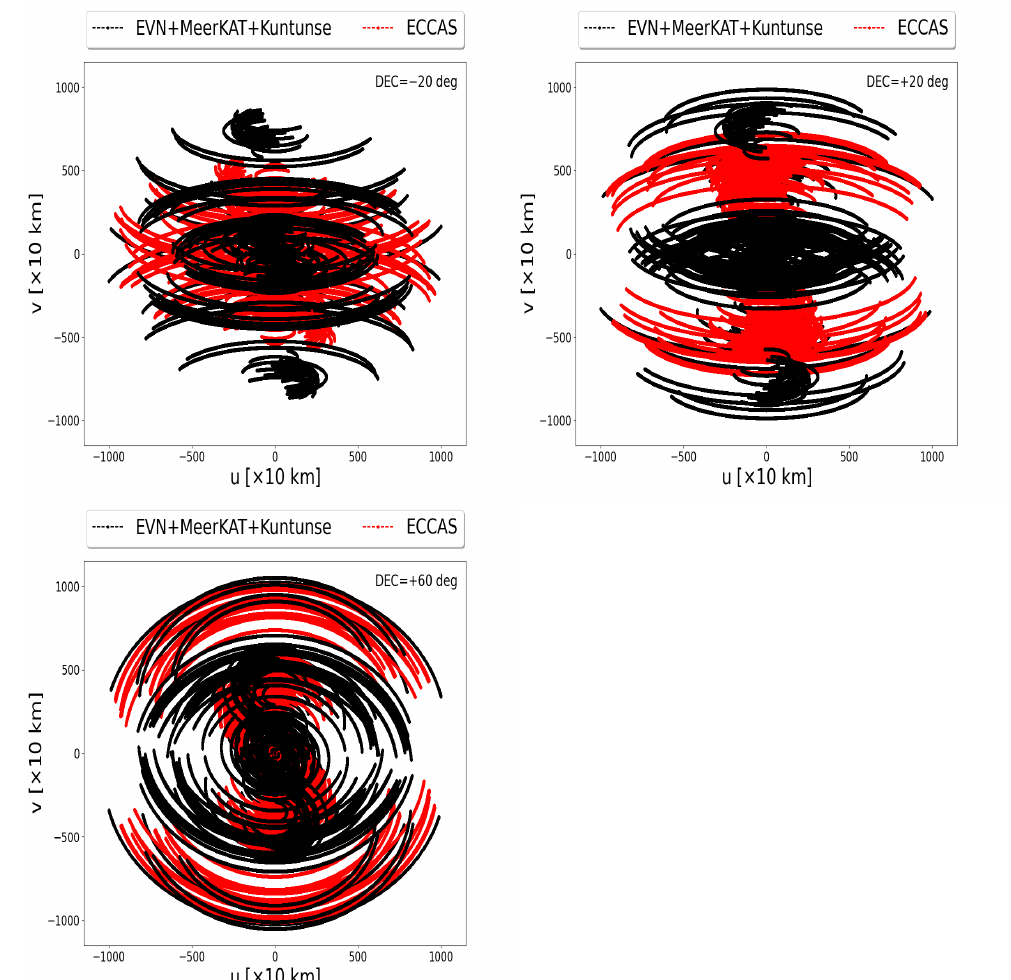
Figure 5. Performance of the global VLBI uv -coverage. The ECCAS antennas are correlated with the Kuntunse antenna, the MeerKAT telescope, and the EVN. The uv -coverage is well-filled because of the extra medium-length baselines that relate the EVN and MeerKAt telescope to the ECCAS